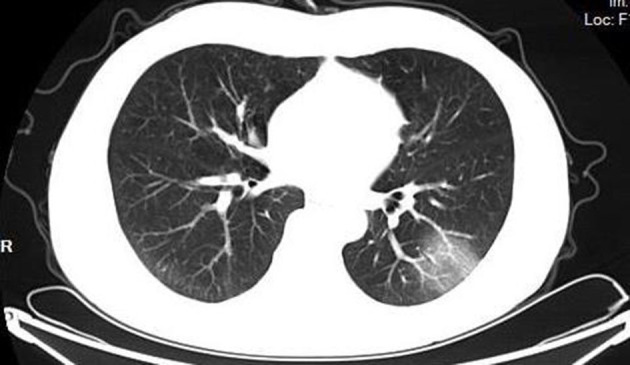
Single ground-glass opacity.